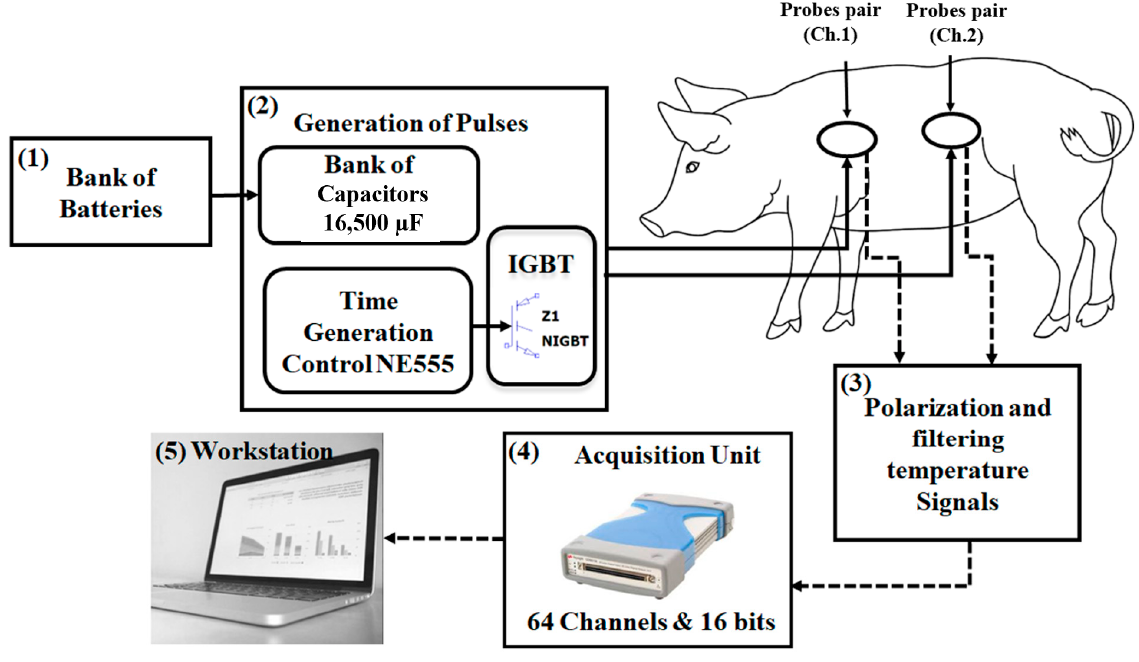
Figure 1. Schematic block diagram of the PLE system.